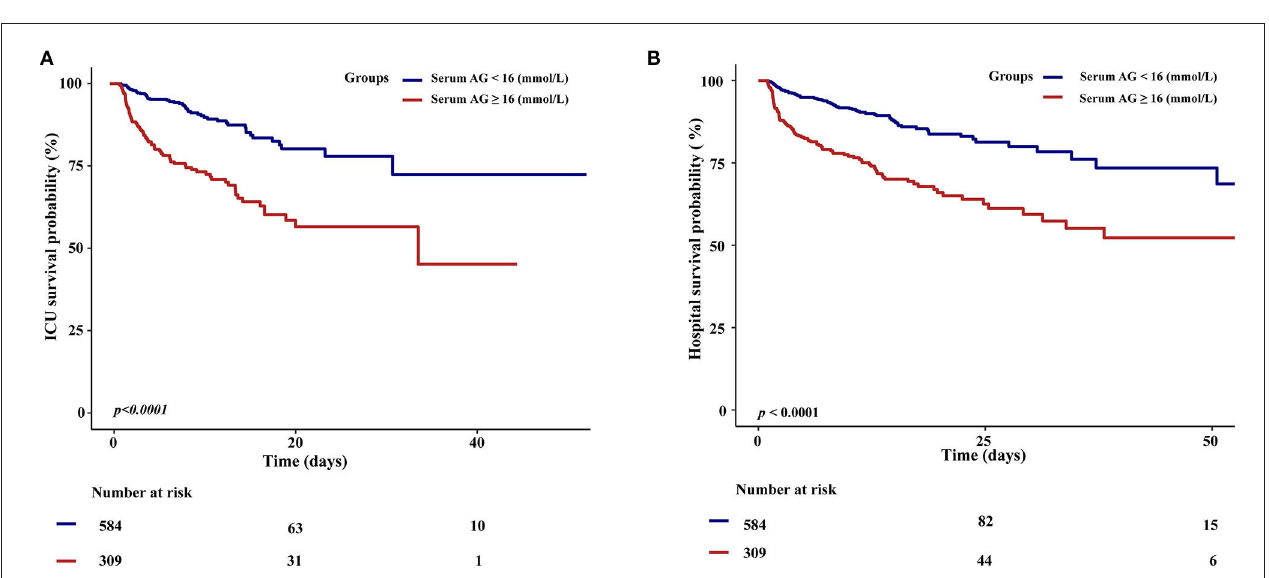
Crude model : adjusted for none. Model I : adjusted for age, sex, and ethnicity.